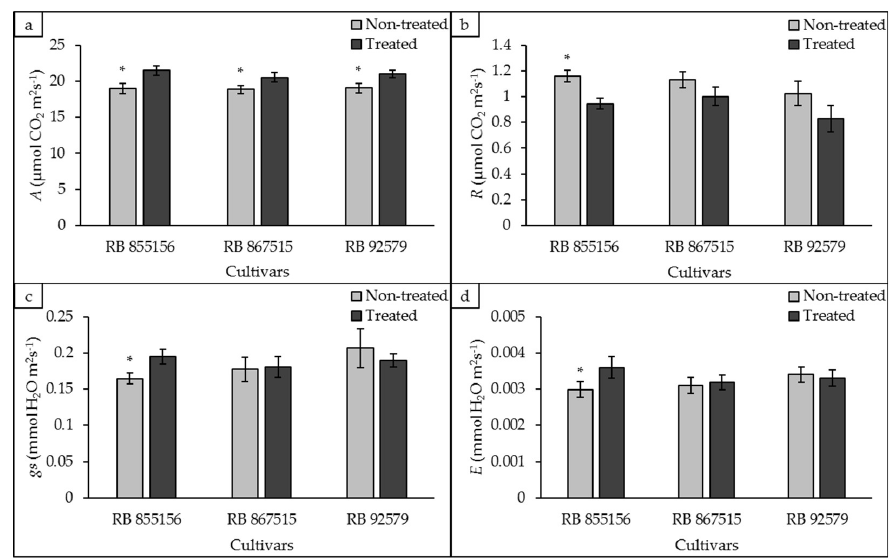
Figure 2. ( a ) Rate of photosynthesis (A), ( b ) stomatal conductance (gs), ( c ) transpiration (E), and ( d ) nocturnal respiratory rate in three sugarcane cultivars treated with the fungicide, pyraclostrobin, in comparison with a control. The results represent the average of nine evaluation times and three replications. * Indicates a significant difference among treatments by the Tukey test at 5% probability. The bar indicates the standard error of the mean.